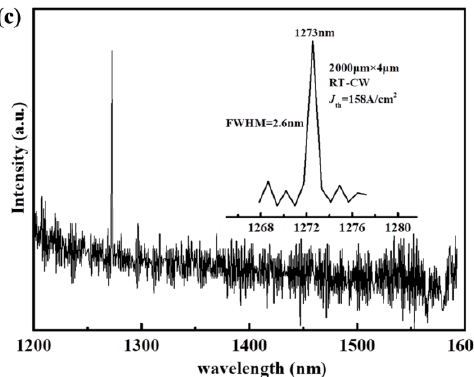
Figure 9. ( a ) Cross-sectional SEM image of the InAs/GaAs QD laser structure after dicing and with the narrow-ridge width of 4 µm; ( b ) L – I – V curve of InAs QD lasers under CW mode at RT; and ( c ) Emission spectrum of InAs QD laser at RT and CW modes. The insert of ( c ) illustrates the magnification of the peak position.